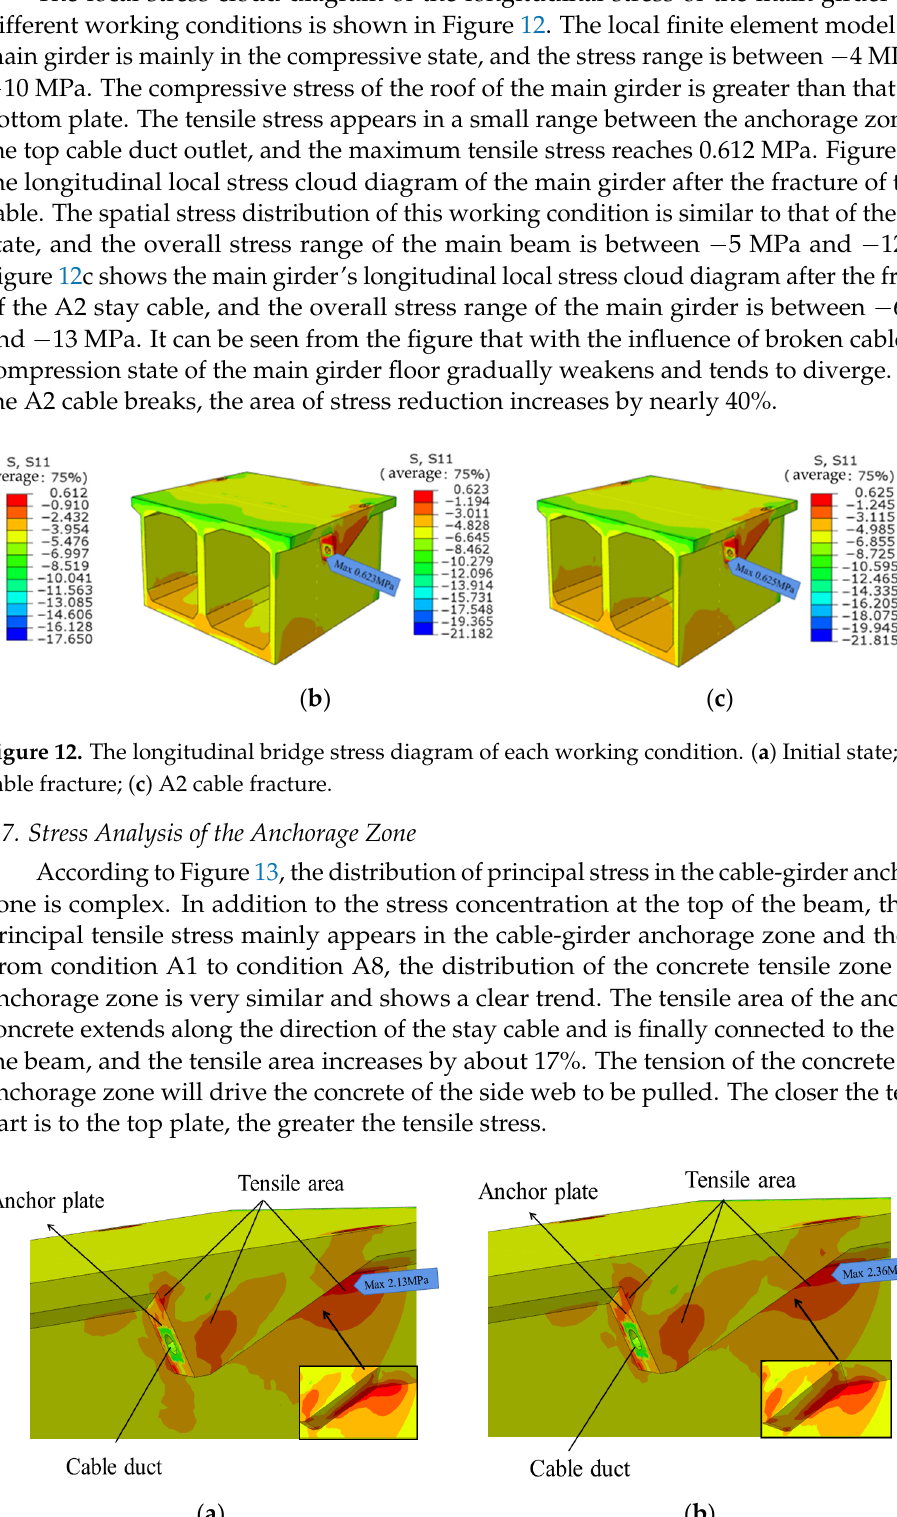
Figure 11. The stress change of the main beam when A1-A8 fracture, respectively. ( a ) Fracture stress distribution of A1–A4; ( b ) fracture stress distribution of A5–A8.